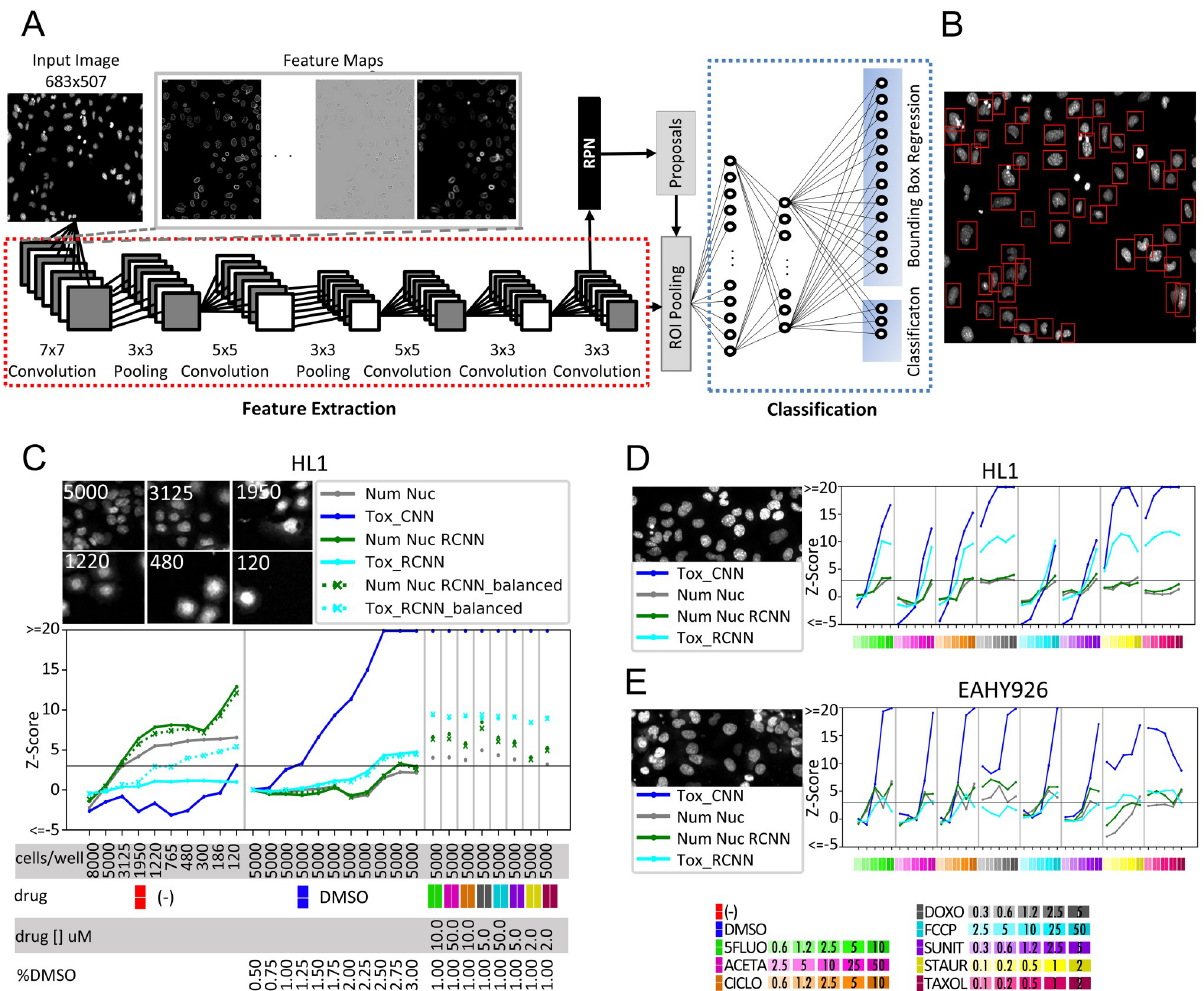
Fig 3. Region-based CNN implementation and evaluation of (R)CNN deep-learning toxicity-assessment approaches. (A) RCNN architecture for automated detection of cells and prediction of their health status from micrographs of DAPI fluorescence, as described in the Materials and Methods. (B) Example of nuclei bounding boxes resulting from the region proposal network included in the RCNN framework. (C) HL1 cells (Experiment #8) were seeded at the indicated densities (cells/well). (D,E) HL1 (Experiment #1) and EAHY926 (Experiment #9) cells were seeded at 5000 cells/well. (C-E) 24h after seeding, cells were treated or not (-) with the indicated concentrations of DMSO (%) or the indicated drugs ( μ M) and processed as described in the Materials and Methods. Representative images are shown of untreated cells at the indicated cell-seeding densities (cells/well). Plots display mean toxicity readouts of four replicate wells, obtained from the percentage of healthy cells predicted by the CNN Nuc (Tox_CNN) and RCNN (Tox_RCNN_balanced and Tox_RCNN) mixed models, and from nuclei counting by standard image segmentation (Num Nuc), or by using RCNN- based automated detection (Num Nuc RCNN) from Tox_RCNN training. For each well, toxicity readouts were obtained by computing Z-scores (normalizing to DMSO-treated wells) with adjustment of the sign to display toxic effects as positive values.